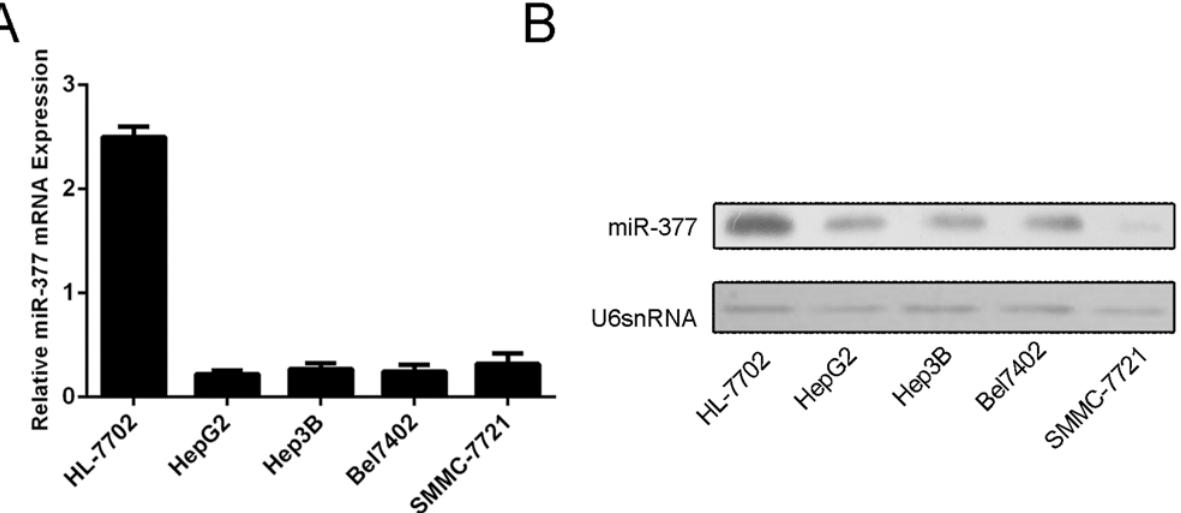
Fig 1. MiR-377 is downregulated in HCC cell lines. (A) Downregulation of miR-377 expression was in HCC cell lines. Relative expression of miR-377 in four HCC cell lines (HepG2, SMMC7721 Hep3B and Bel7402) and one normal human hepatocyte (HL-7702) was determined by qRT-PCR. U6 snRNA was used as internal control. (B) Northern blot analysis of miR-377 in four HCC cell lines (HepG2, SMMC7721 Hep3B and Bel7402) and one normal human hepatocyte (HL-7702). U6 snRNA was also detected as a loading control.